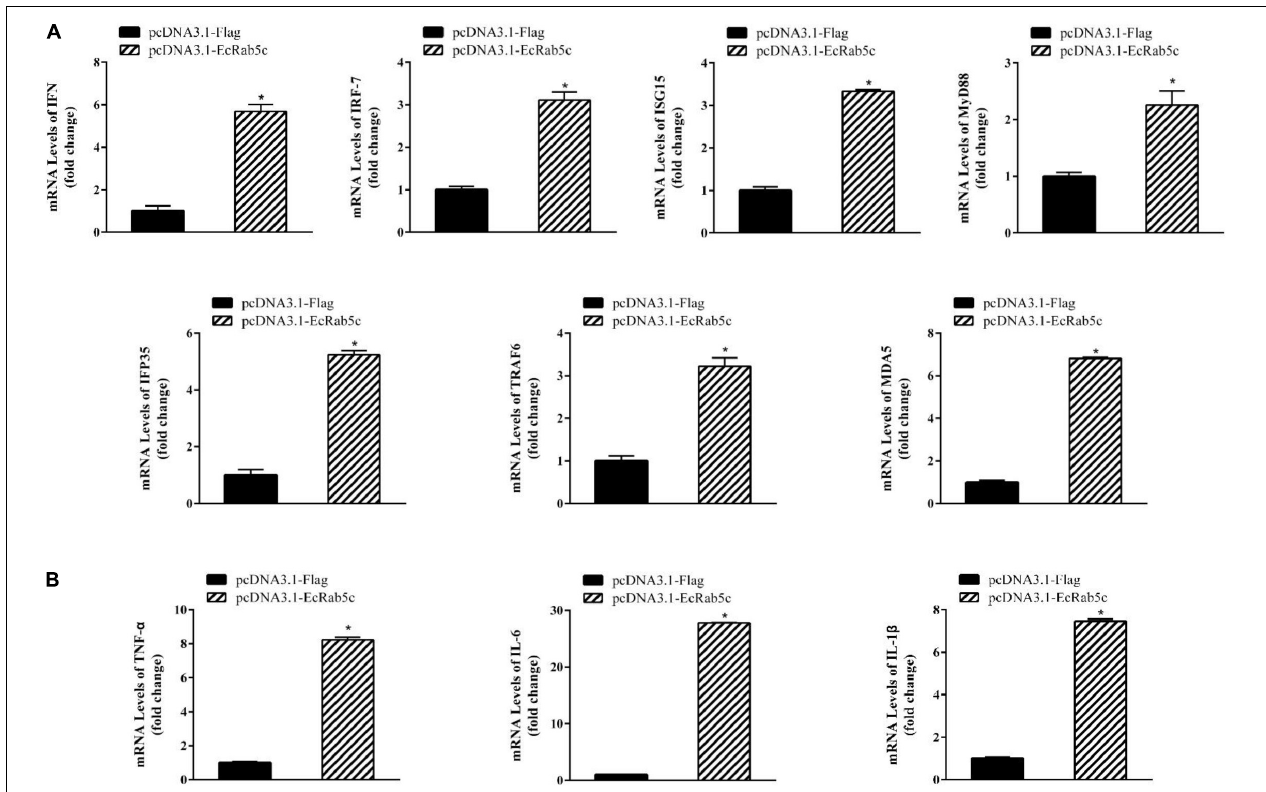
FIGURE 9 | Overexpression of EcRab5 positively regulated IFN-signaling molecules (A) including IFN, IRF-7, ISG15, MyD88, IFP35, TRAF6, MDA5, and pro-inflammatory cytokines (B) including TNF- α , IL-6, and IL-1 β . GS cells were transfected with pcDNA3.1-Flag or pcDNA3.1-EcRab5c. After 24 h, the cells were collected for qRT-PCR ( n = 3, mean ± SEM). * p <